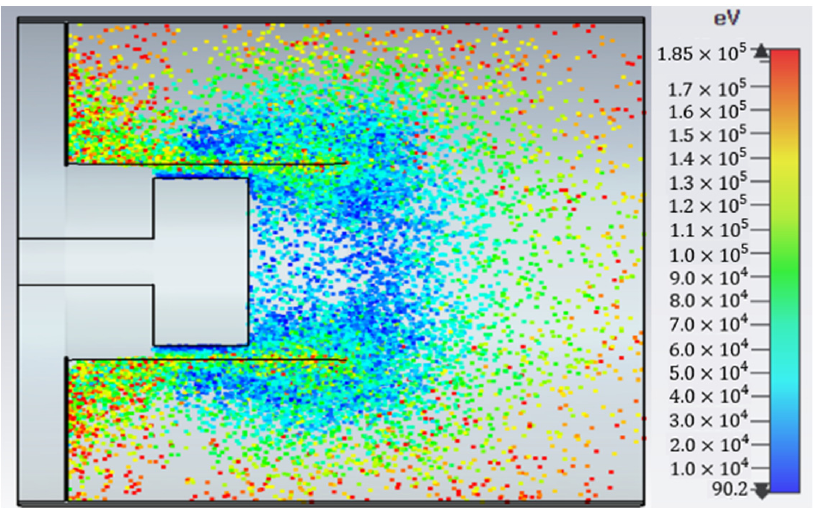
Figure 6. Two-dimensional (2D) electron energy distribution plot on the proposed coaxial vircator (D AK = 6 mm).